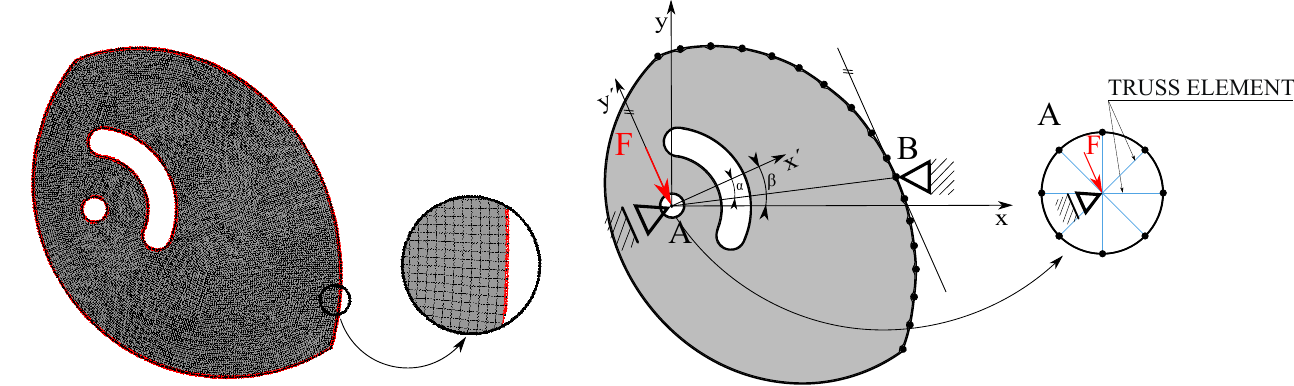
Figure 6. The finite element mesh used for description of the cam ( left ) and boundary conditions of linear computational model ( right